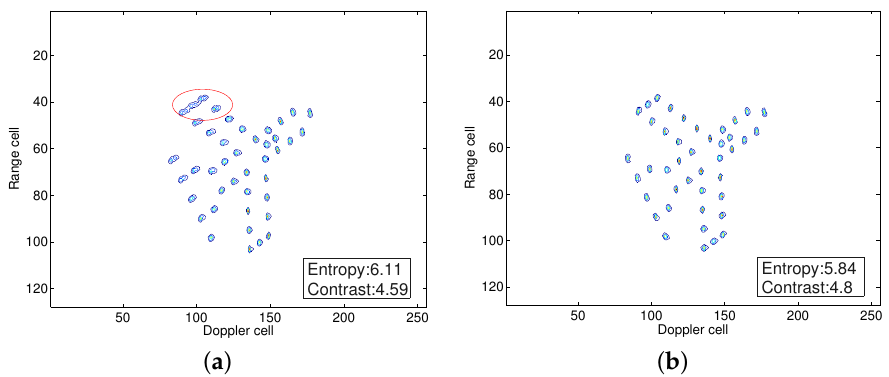
Figure 5. ISAR images of an airplane model. ( a ) ISAR image based on adaptive MFT. ( b ) ISAR image based on adaptive MFT with DFS